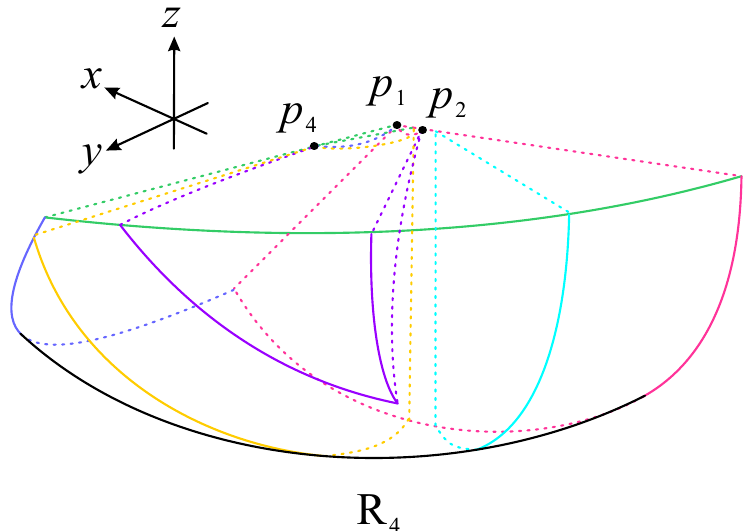
Figure 8. The purple surface is b 1 = 0, the yellow plane is b 2 = 0, and the light blue plane is b 3 = 0.